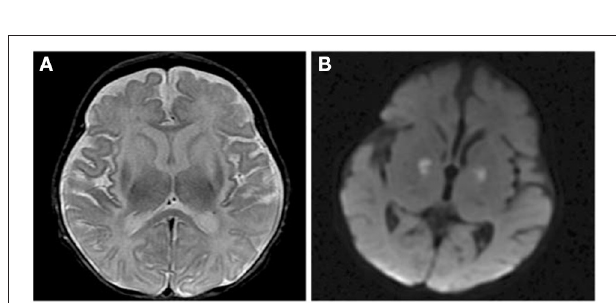
FIGURE 5 | Axial T2 (A) and diffusion brain MR (B) images through the basal ganglia from a 13 day old female with CPSD1 deficiency. Symmetric basal ganglia and insular cortex hyperintensity reflects edema and laminar necrosis in the setting of subacute hyperammonemic injury. Reduced diffusion in the globi pallidi may represent more acute injury due to secondary energy failure or subacute pre-wallerian